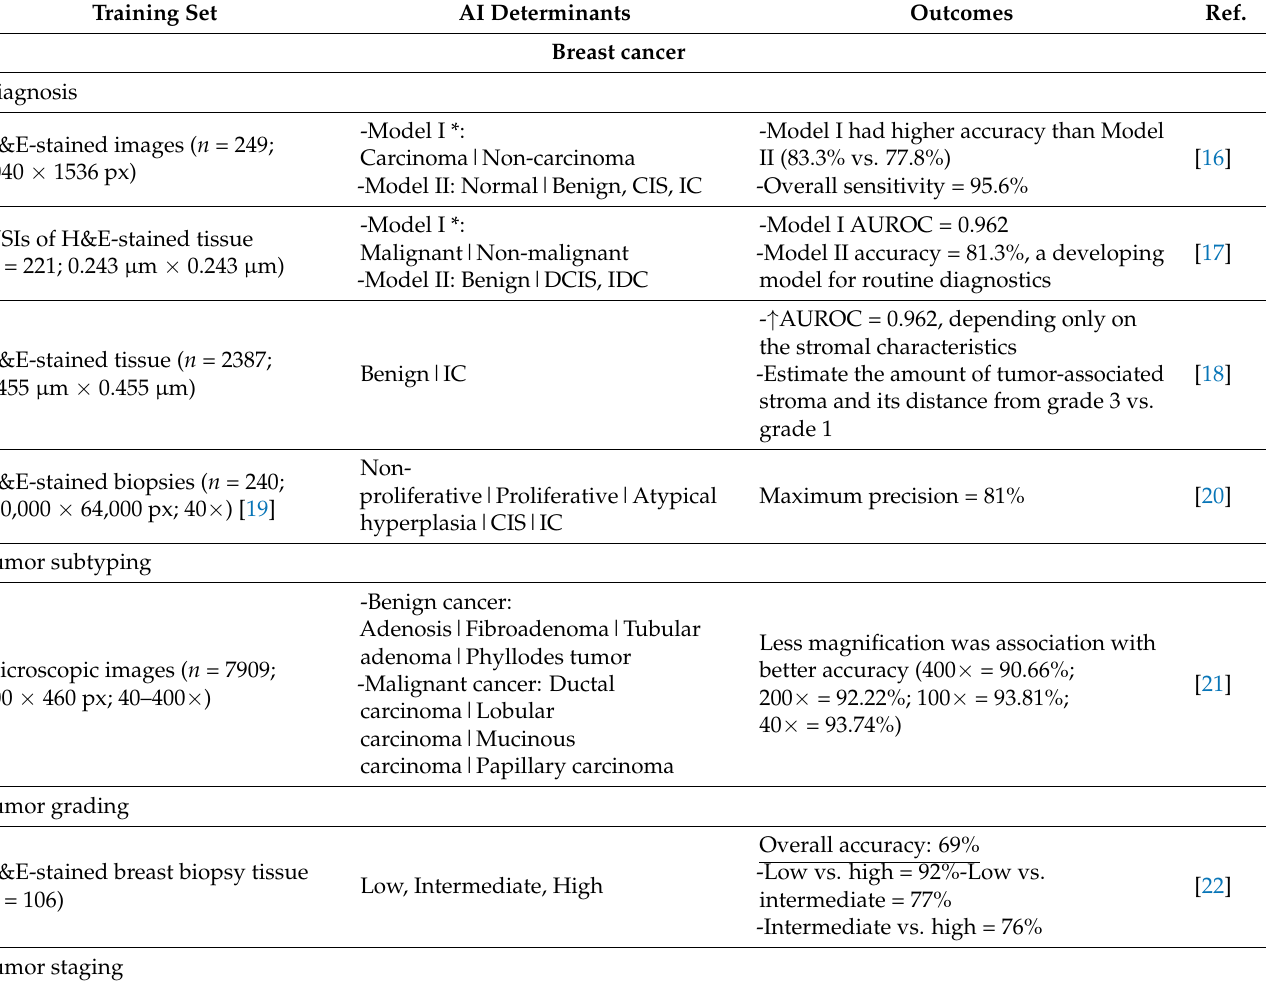
Table 1. AI applications in tumor